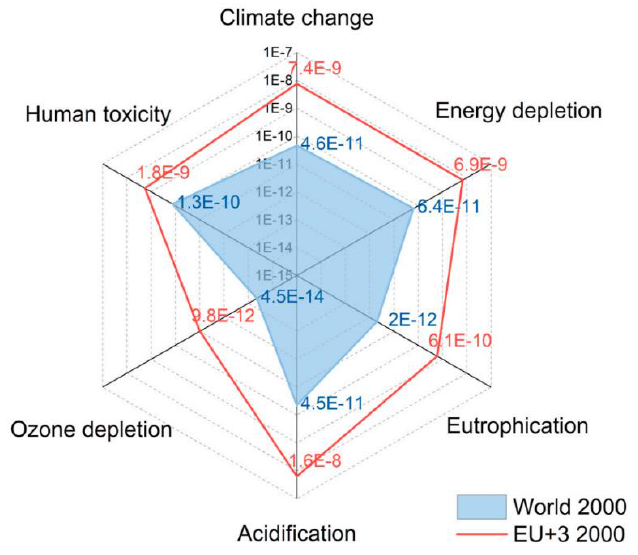
Figure 2. Normalized medians of impact categories for the entire life cycle of buildings (50-years’ service life). Source: Dong, Y.; Ng, S.T.; Liu, P. A comprehensive analysis towards benchmarking of life cycle assessment of buildings based on systematic review. Building and Environment 2021 , 204 , 108162, https://doi.org/10.1016/j.buildenv.2021.108162, p. 12 [71].